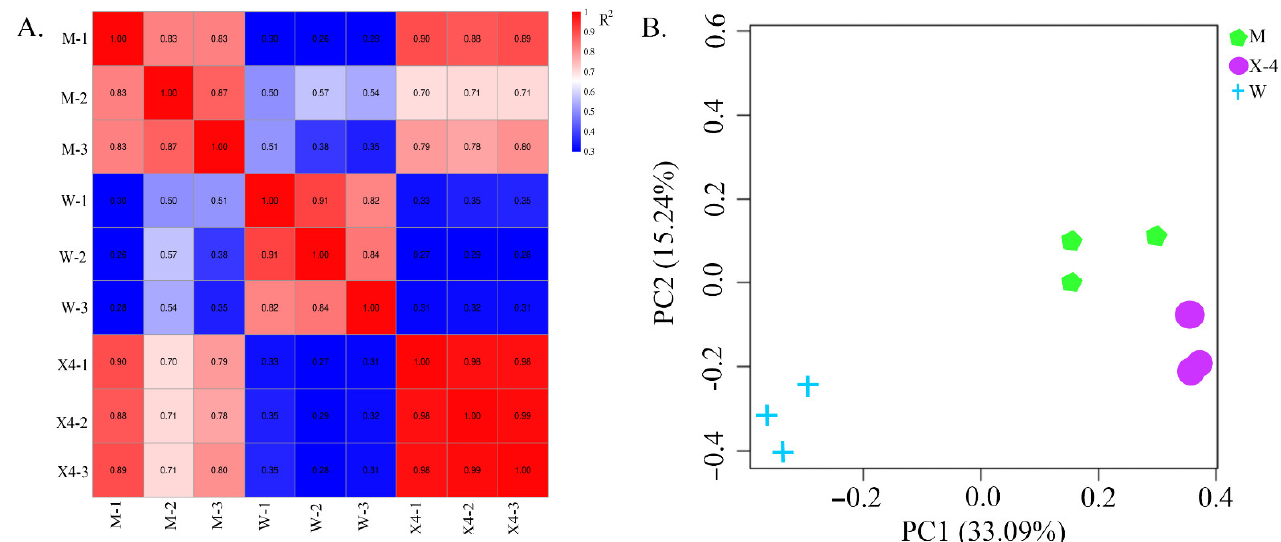
Figure 2. ( A ) Pearson’s correlation matrix and ( B ) principle component analysis of differentially expressed genes (DEGs) to evaluate correlations and variance between samples. Three biological replicates of each sample set were performed. X4, Xinxuan-4; M, Mahan; W, Wichita.